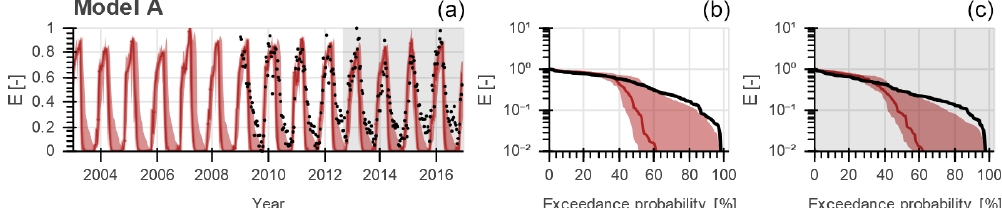
Figure 5. Range of model solutions for Model A. Panel (a) shows the time series and (b, c) the duration curve of the recorded (black) and modelled normalized evaporation for wetland-dominated areas: the line indicates the solution with the highest calibration objective function with respect to discharge ( D E ,Q cal ) and the shaded area the envelope of the solutions retained as feasible. The data in the grey shaded area were used for validation.